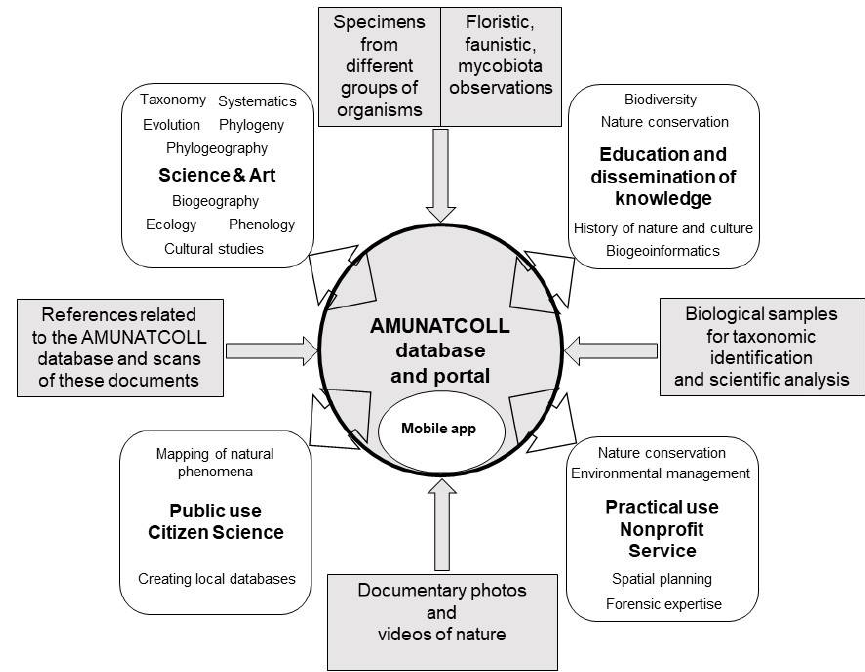
Figure 2. Conceptual model of digitized natural history collections open to science, education, public, and practical (SEPP) use.